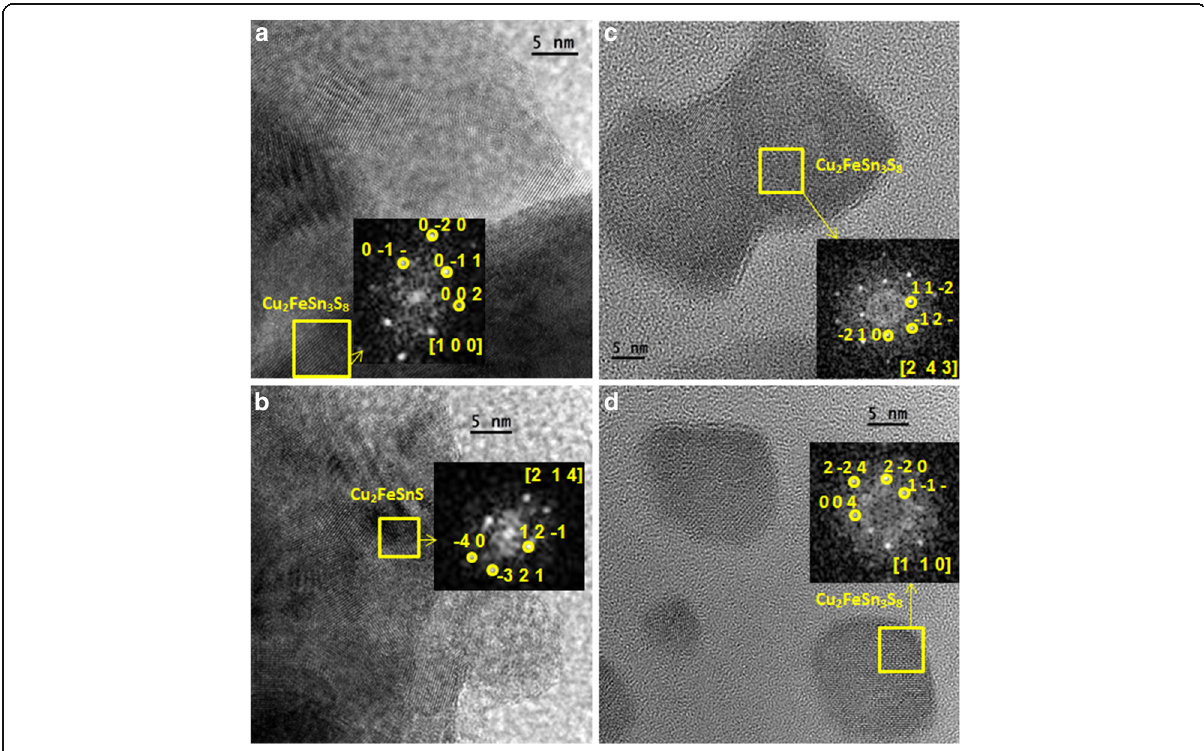
Fig. 8 HRTEM images of the CFTS sample. The micrographs show the agglomerated nanocrystals ( a , b ) and isolated crystallites ( c , d ). The yellow squares display oriented crystallites, the corresponding FFT is depicted in the insets , and the zone axes and (h, k, l) of the corresponding phase are marked in